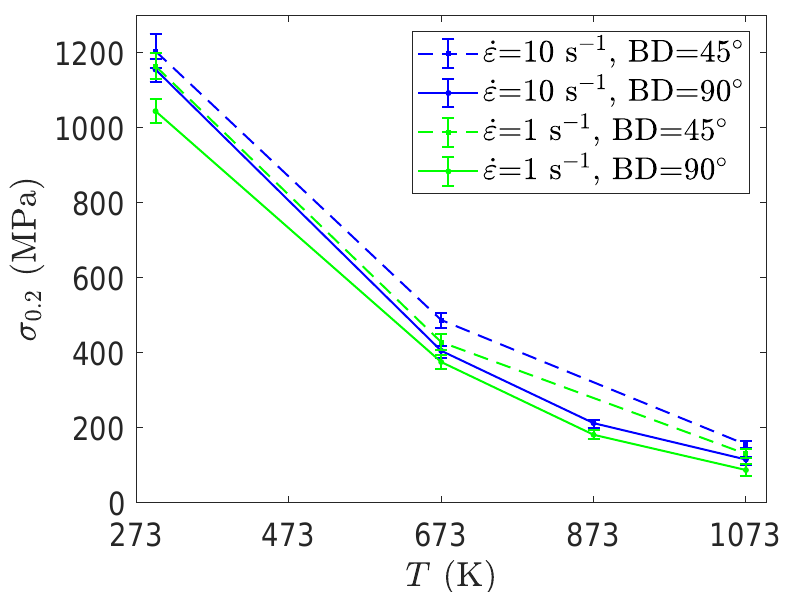
Figure 8. Variation of the strength coefficient σ 0.2 for the Ti42Nb alloy produced with two building directions as a function of temperature.